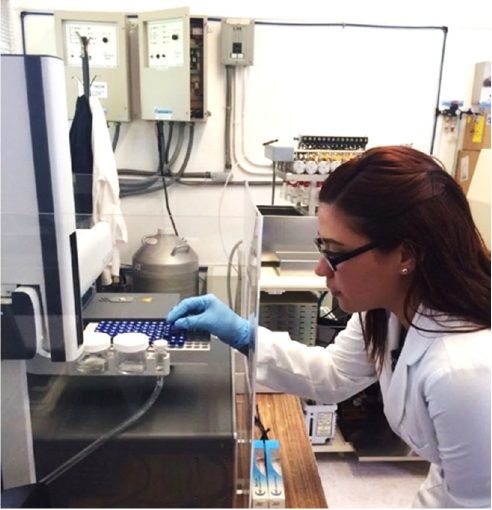
Figure 3. Analyzing stable isotopes ( δ 18 O) samples at the Isotopic Hydrologic Laboratory (Laser analyzer Cavity Ringdown Spectrometer L2110-i Isotopic H 2 O Picarro with high precision vaporizer